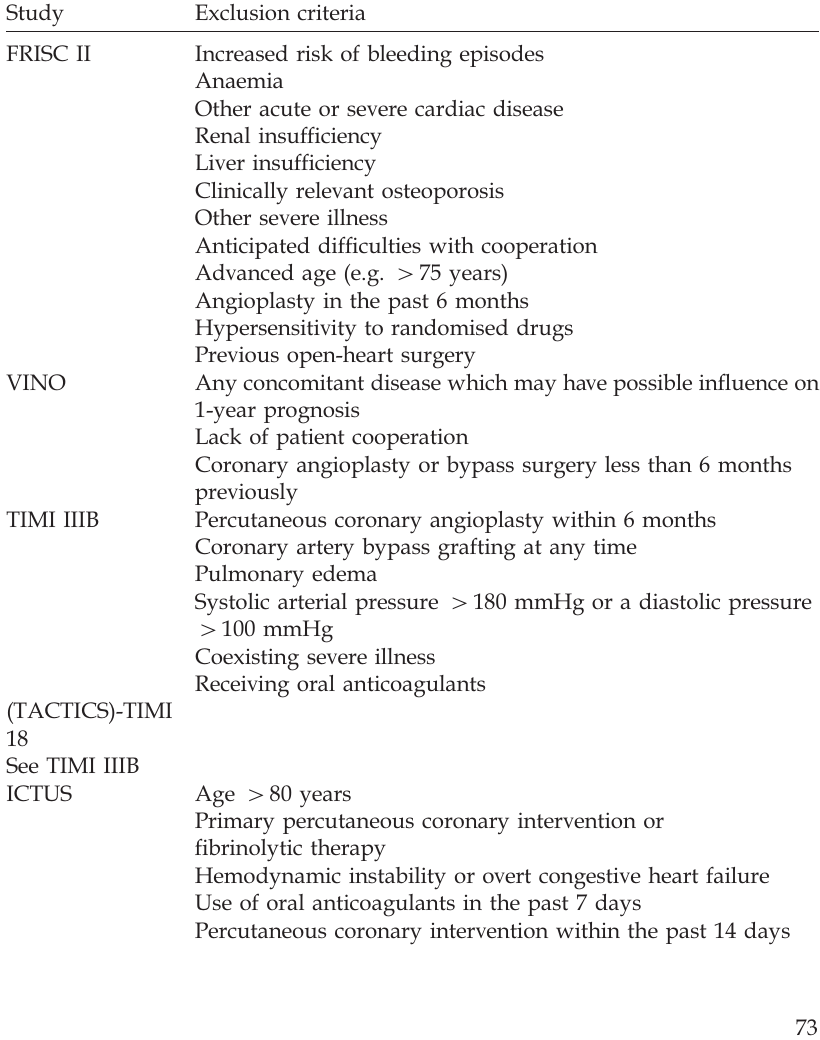
Table 1. Reported exclusion criteria, regarding age, co-morbidity and other conditions for patients with acute coronary syndromes, in fi v e e v idence-generating RCTs cited in two meta-analyses (Hoenig et al. 2006; Metha et al.